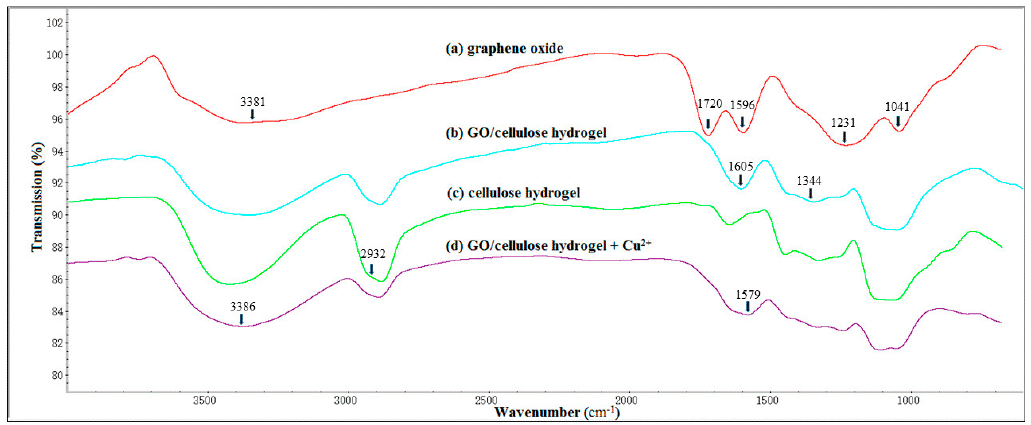
Figure 1. FTIR spectra of GO, GO/cellulose hydrogel, cellulose hydrogel, and Cu(II)-loaded GO/cellulose hydrogel.